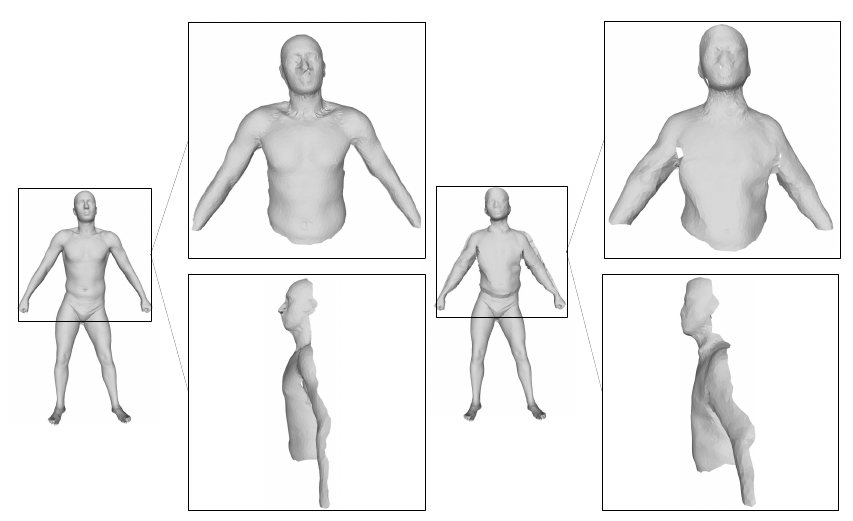
Figure 7. We obtain the dense reconstruction of upper parts of the body. The left figure is our template driven by the current reference frame before deformation. The right figure is an instance obtained through deforming several body parts of our template.